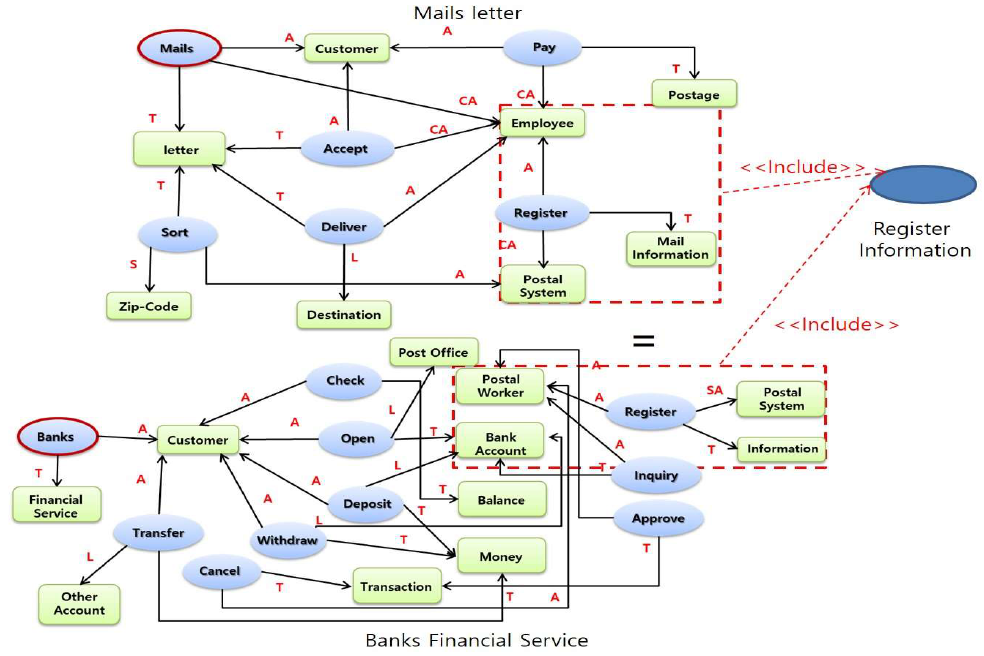
Figure 13. Inclusion relationship.